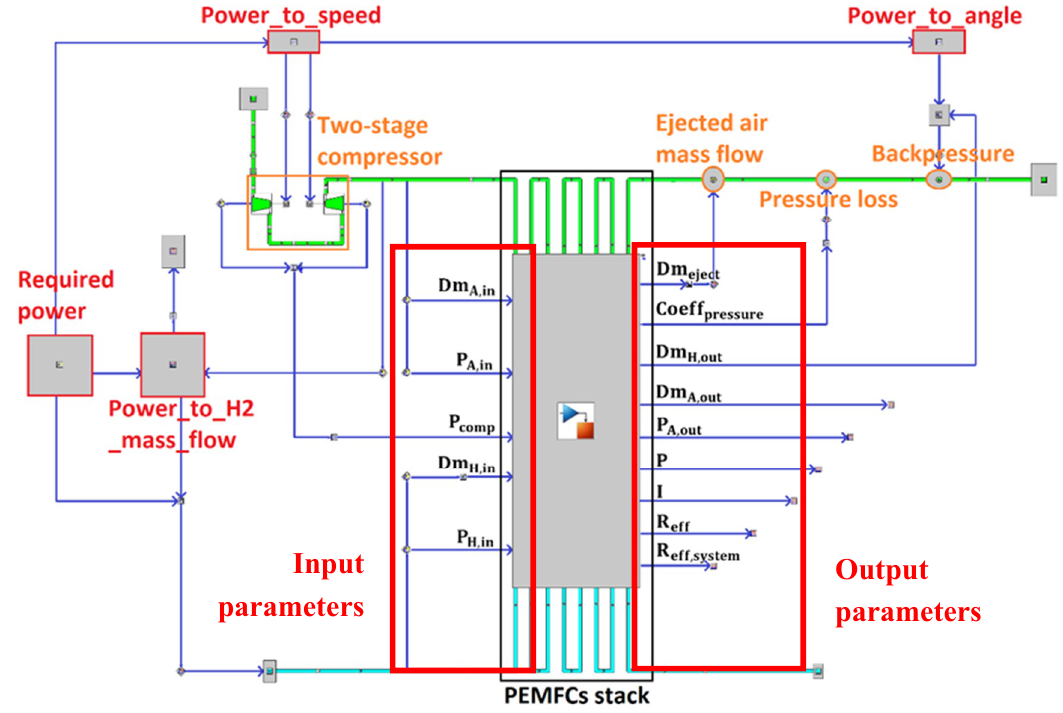
Figure 3. GT-SUITE diagram of a proton exchange membrane fuel cell (PEMFCs) stack model equipped with a two-stage electric compressor.